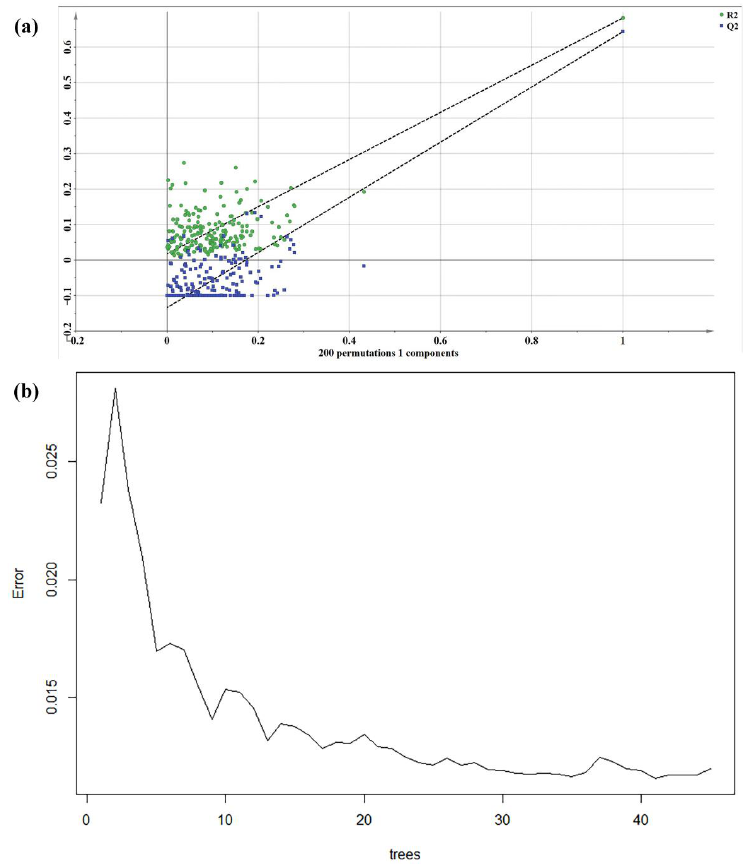
Figure 5. Validation of models. ( a ) Permutation test of partial least squares regression model. Criteria for model validation: all the R 2 and Q 2 are smaller than the original values according to the se- quence distribution of the partial least squares regression model for the 250 m buffer zone; ( b ) Gen- eralization error and number of regression trees of the random forest model. The number of regres- sion trees corresponding to the minimum error value is selected.